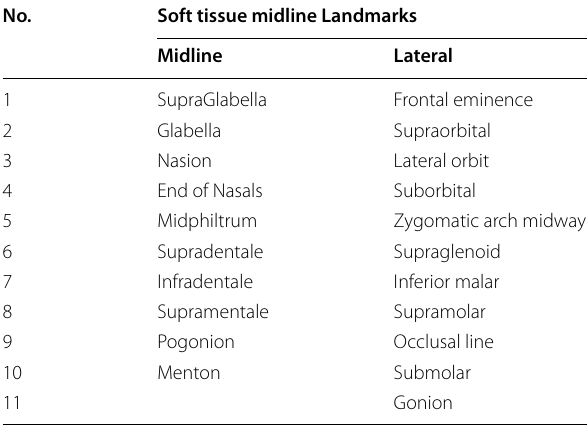
Table 4 Midline soft tissue landmarks for FSTT (Taylor 2000; Jasuja et al. 2018)